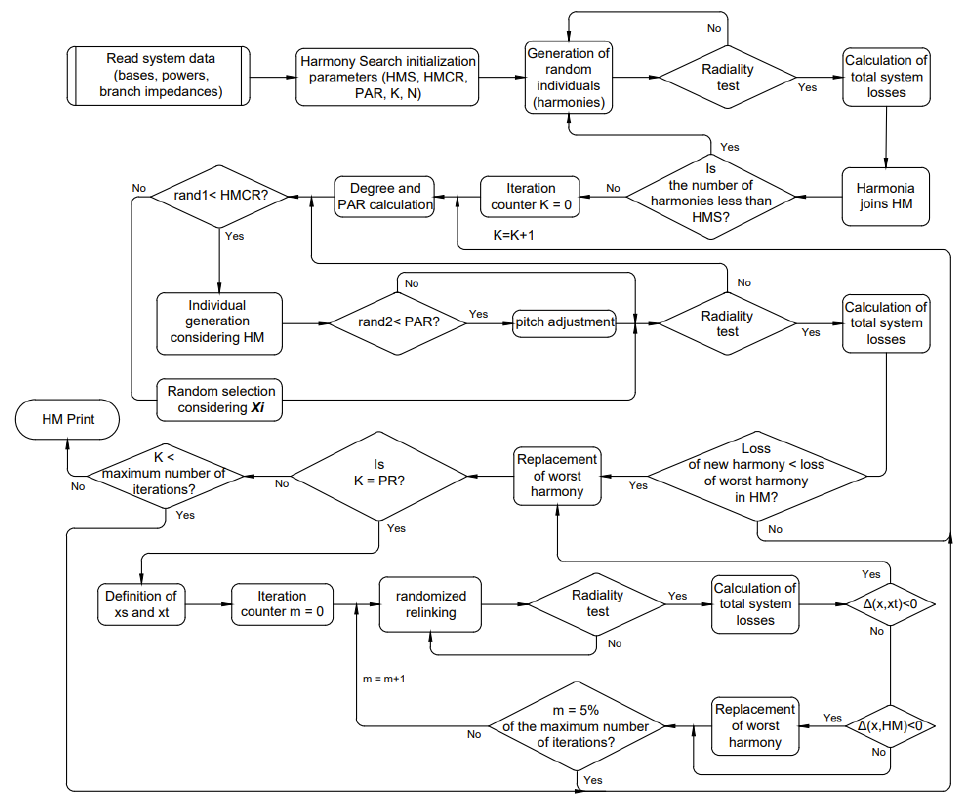
Figure 2. Implementation of the IHS and Path Relinking algorithm to the DSR